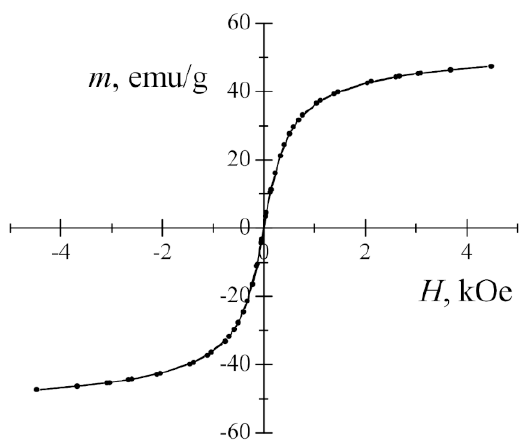
Figure 3. Magnetization dependence of maghemite/magnetite nanoparticles on the applied mag- netic field.